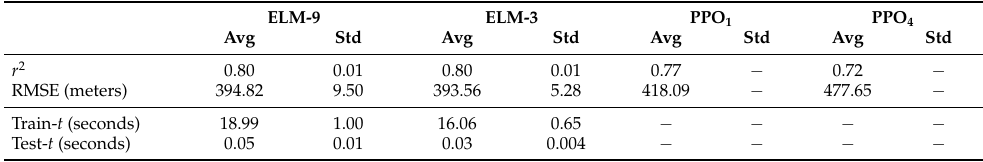
Table 16. Prediction error results by the ELM and PPO approaches, and computational running time (Train- t and Test- t ) by ELM.